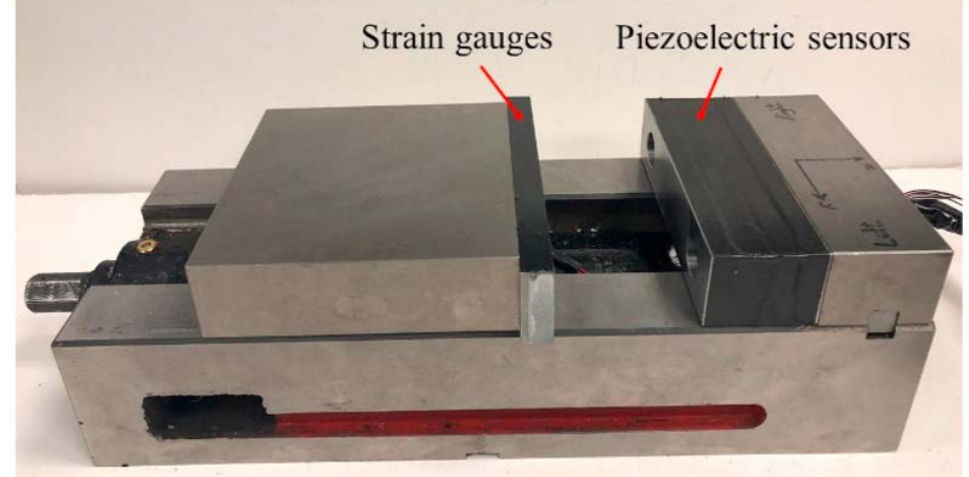
Figure 4. A prototype integrated with jaws embedded in strain gauges and piezoelectric sensors [65].